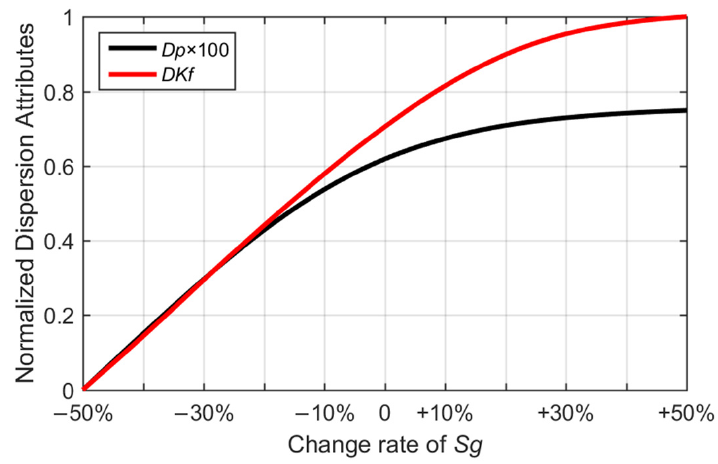
Figure 9. Normalized dispersion attributes D Kf and 100 × D P for the realistic models with continu ‐ ously varied S g in the tight sandstones.